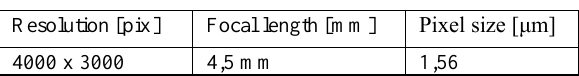
Table 4 . Olympus TG-6 camera main technical